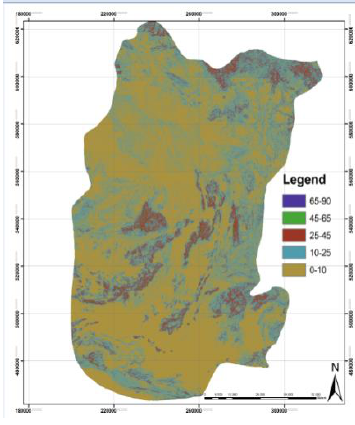
Figure 4. Slope classification map